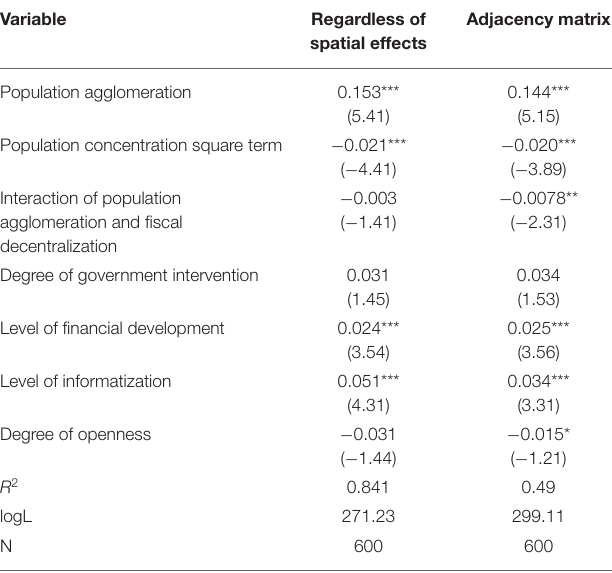
TABLE 7 | Test results of the moderating mechanism of population agglomeration affecting high-quality development.